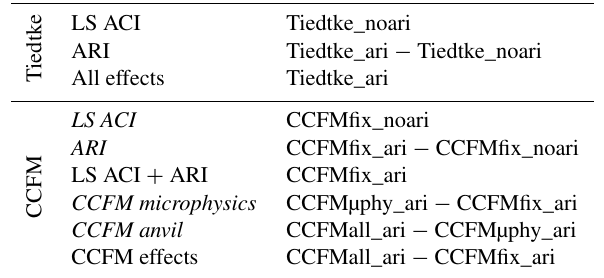
Table 2. The separate contributions of each mechanism to the total aerosol effect are extracted by taking the difference between pairs of simulations. (ARI: aerosol–radiation interactions; LS ACI: large- scale aerosol–cloud interactions; CCFM microphysics: changes to autoconversion in convective cloud; CCFM anvil: changes to size distribution of detrained condensate). See Sect. 2.3 for more de- tails. The italic entries indicate the detailed subdivision of individ- ual mechanisms as shown in the Supplement; those in Roman face indicate the total large-scale (LS ACI + ARI) and total CCFM ef- fects shown in the main